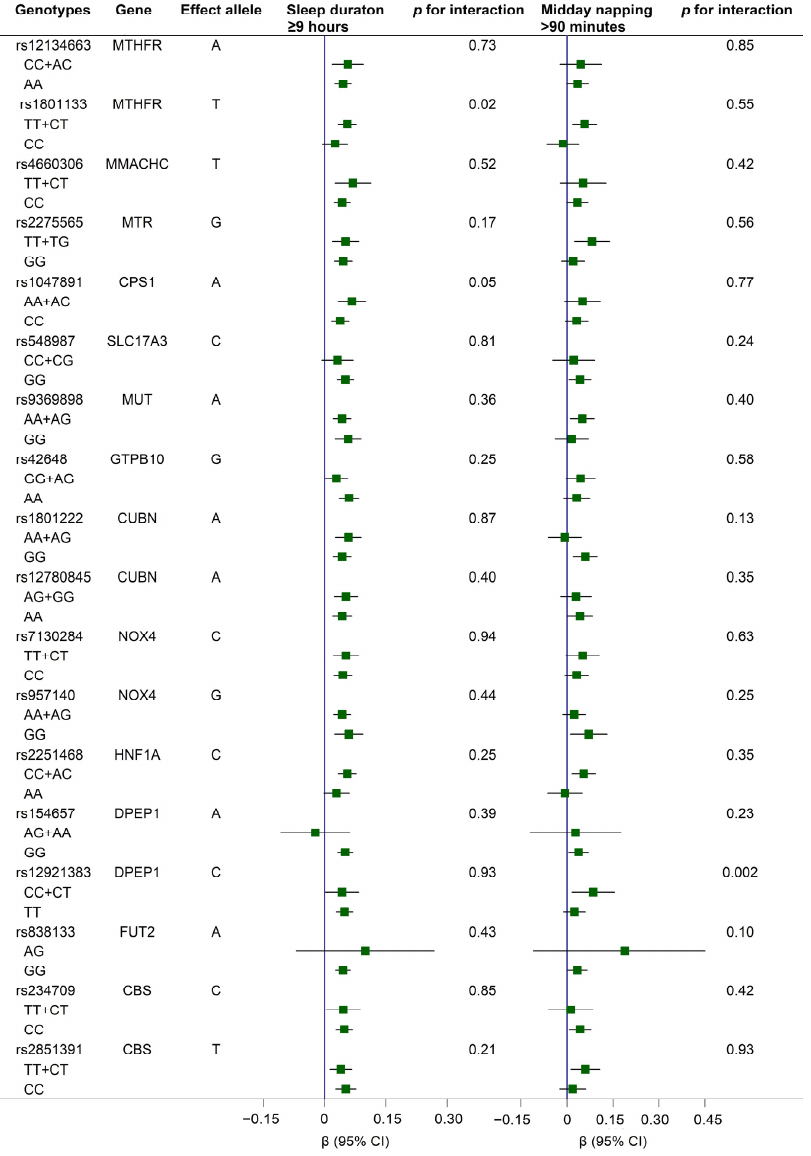
Figure 2. Associations of long sleep duration ( ≥ 9 h) and middy napping (>90 min) with serum Hcy levels according to genotypes of 18 Hcy-related variants. Generalized linear regression models were conducted, with adjustments for age (continuous), sex (female, male), education level (primary school or below, middle school, high school or higher), body mass index (continuous), presence of hypertension, dyslipidemia, and diabetes (yes, no), smoking status (current, former, never), drinking status (current, former, never), dietary intake of meat, milk or dairy products, beans or soy products, fish or seafood, and fruits or vegetables ( ≥ 5 times/week; yes, no), regular exercise (yes, no), snoring (yes, no), sleep quality (good, fair, poor), sleep duration (continuous), and midday napping (continuous); in addition, sleep duration (continuous) was adjusted for investigation of the gene– napping interaction in Hcy, and midday napping (continuous) was adjusted for investigation of the gene–sleep interaction in Hcy. Interactions were tested by modeling the product terms of genotypes with sleep duration or midday napping (all as continuous variables) into the multivariable-adjusted models, respectively. Note: The rs838133-AA genotype was not detected in the present study. CI, confidence interval; Hcy,